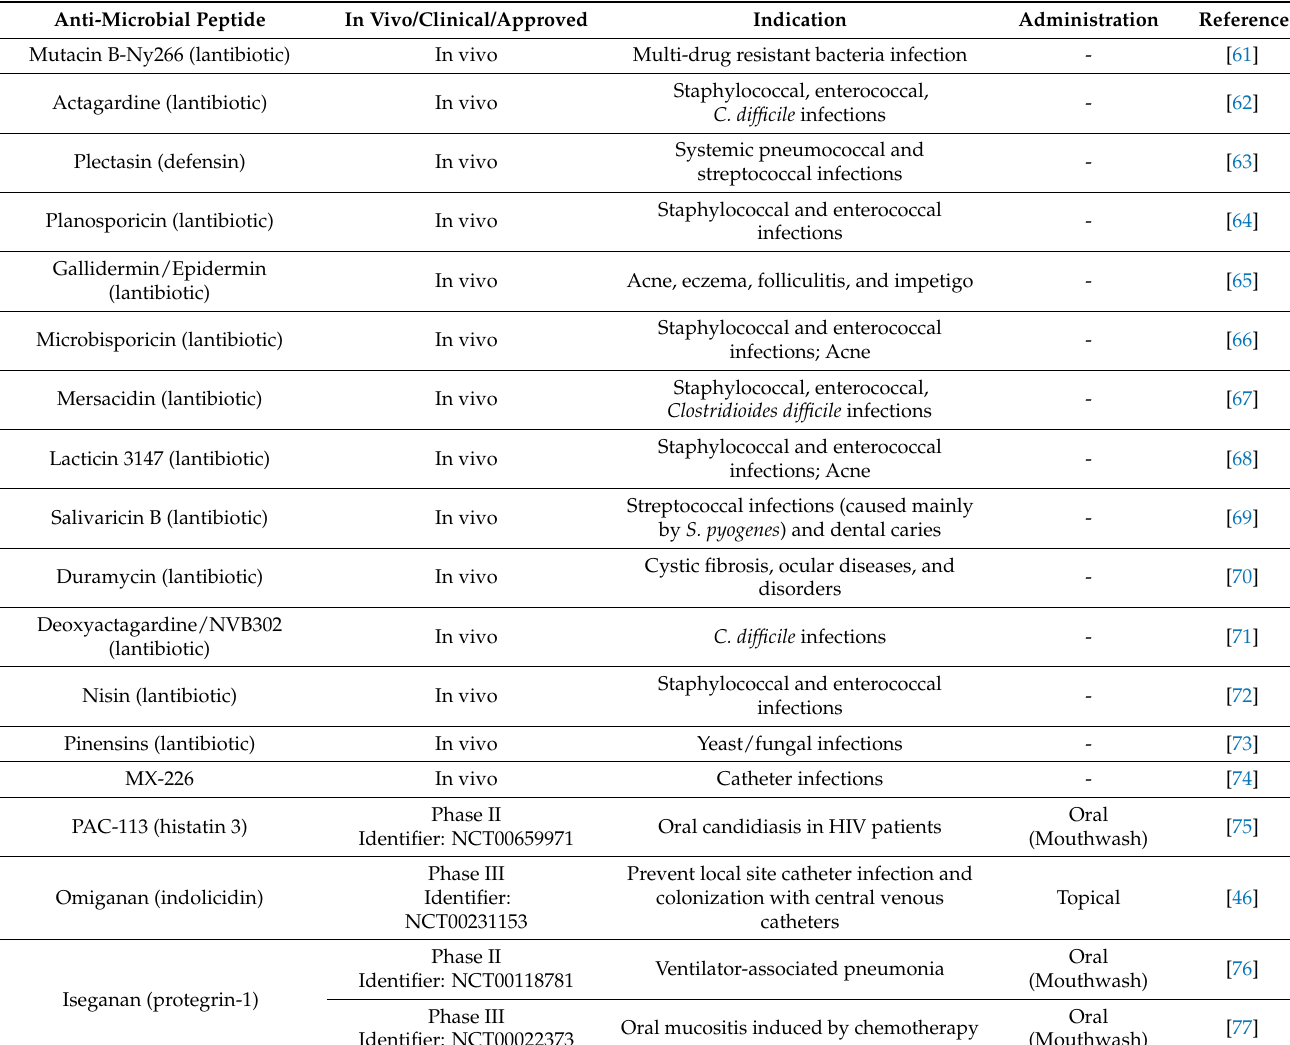
Table 1. List of few AMPs at various stages of clinical